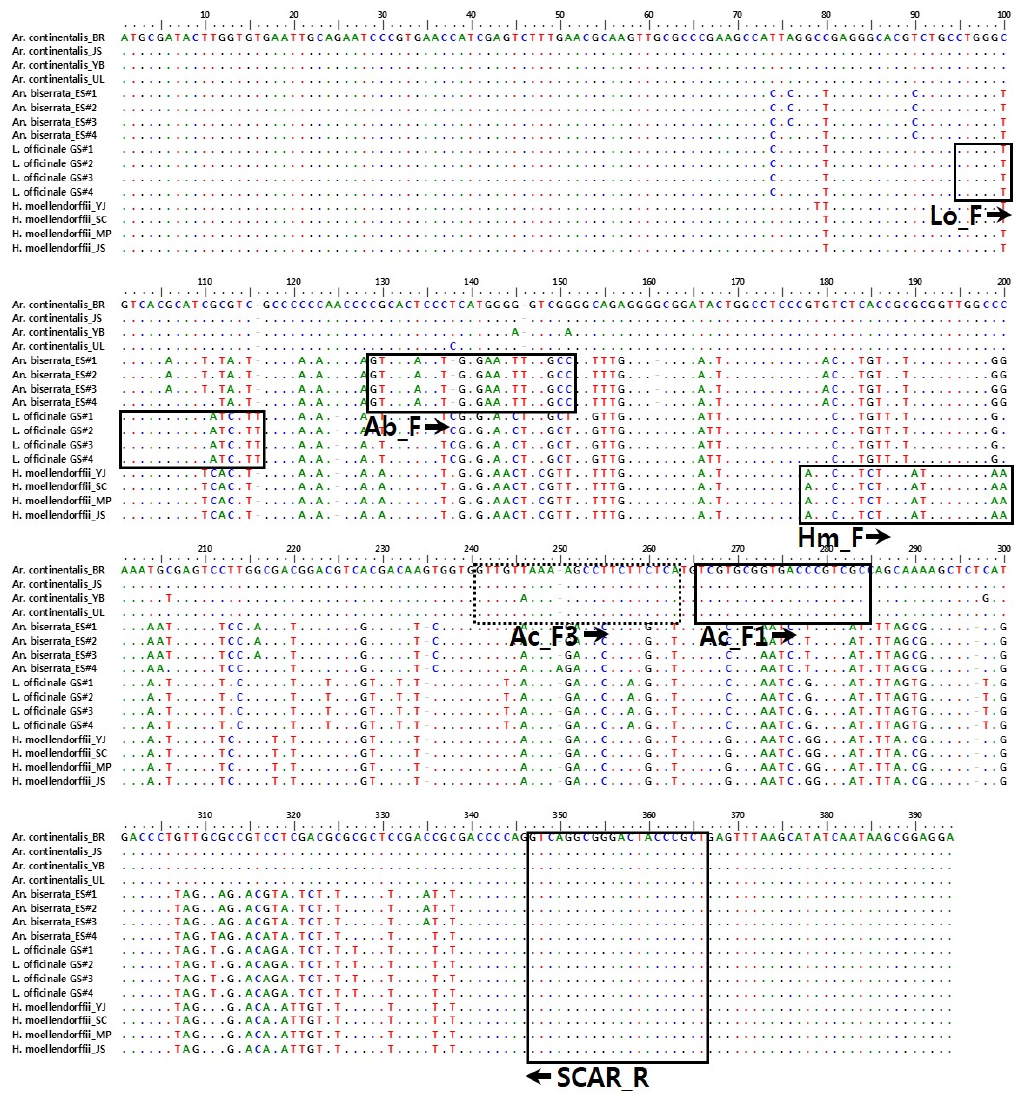
Figure 1. Comparative analysis of ITS2 sequences and design of species-specific SCAR primers. Boxes indicate SCAR primer sequences used in this study. Primer names are indicated under the boxes.